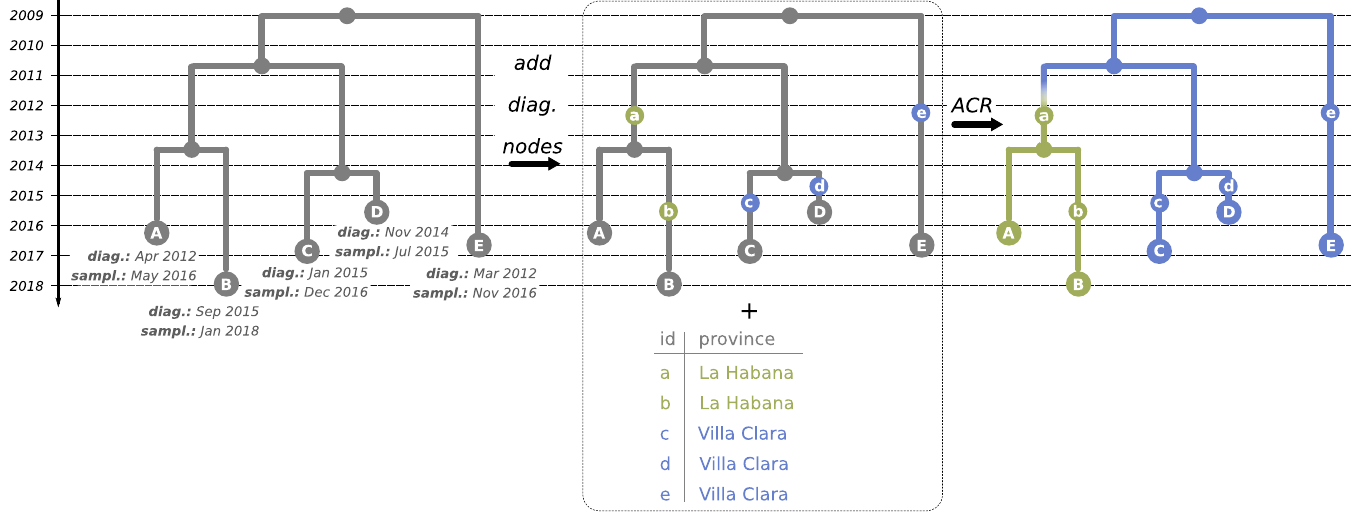
Fig 6. ACR for provinces of Cuba. To reconstruct the ancestral states for characters annotated at diagnostics dates (such as provinces of Cuba), we added additional nodes to the time-scaled trees at times of diagnostics, named those nodes (on the middle panel, the diagnostics nodes, e.g. a , correspond to the tips with the same names but capitalised, e.g. A ), and associated the input annotations for PastML with them. We then reconstructed ancestral and tip characters with PastML based on those annotations (see text for calculation details).